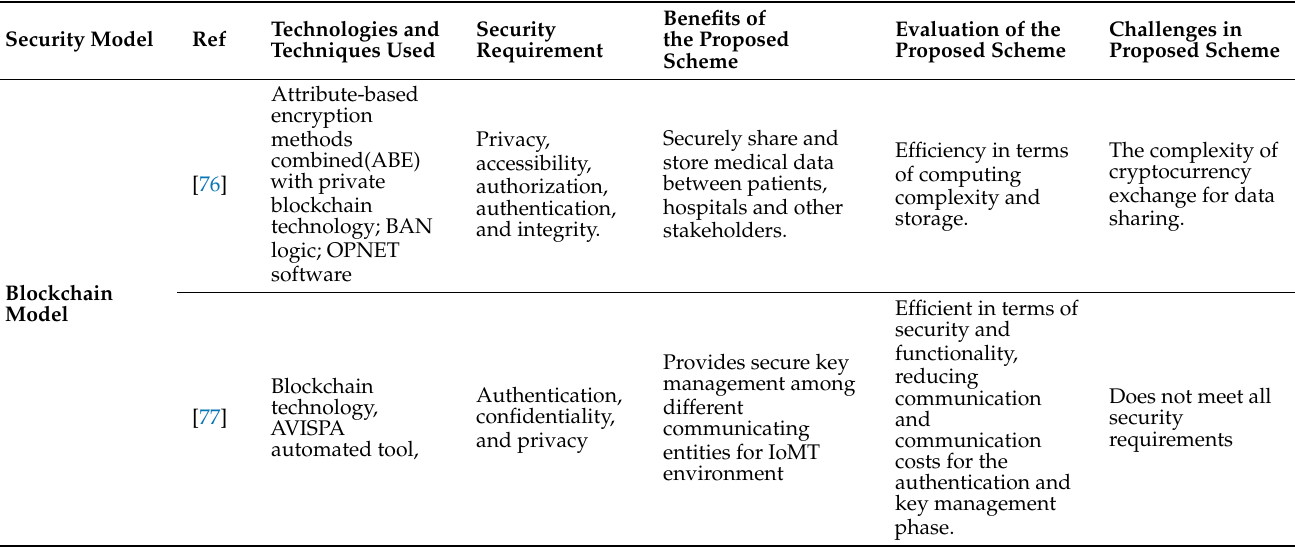
Table 5. The summary of the studies reported on the security and privacy